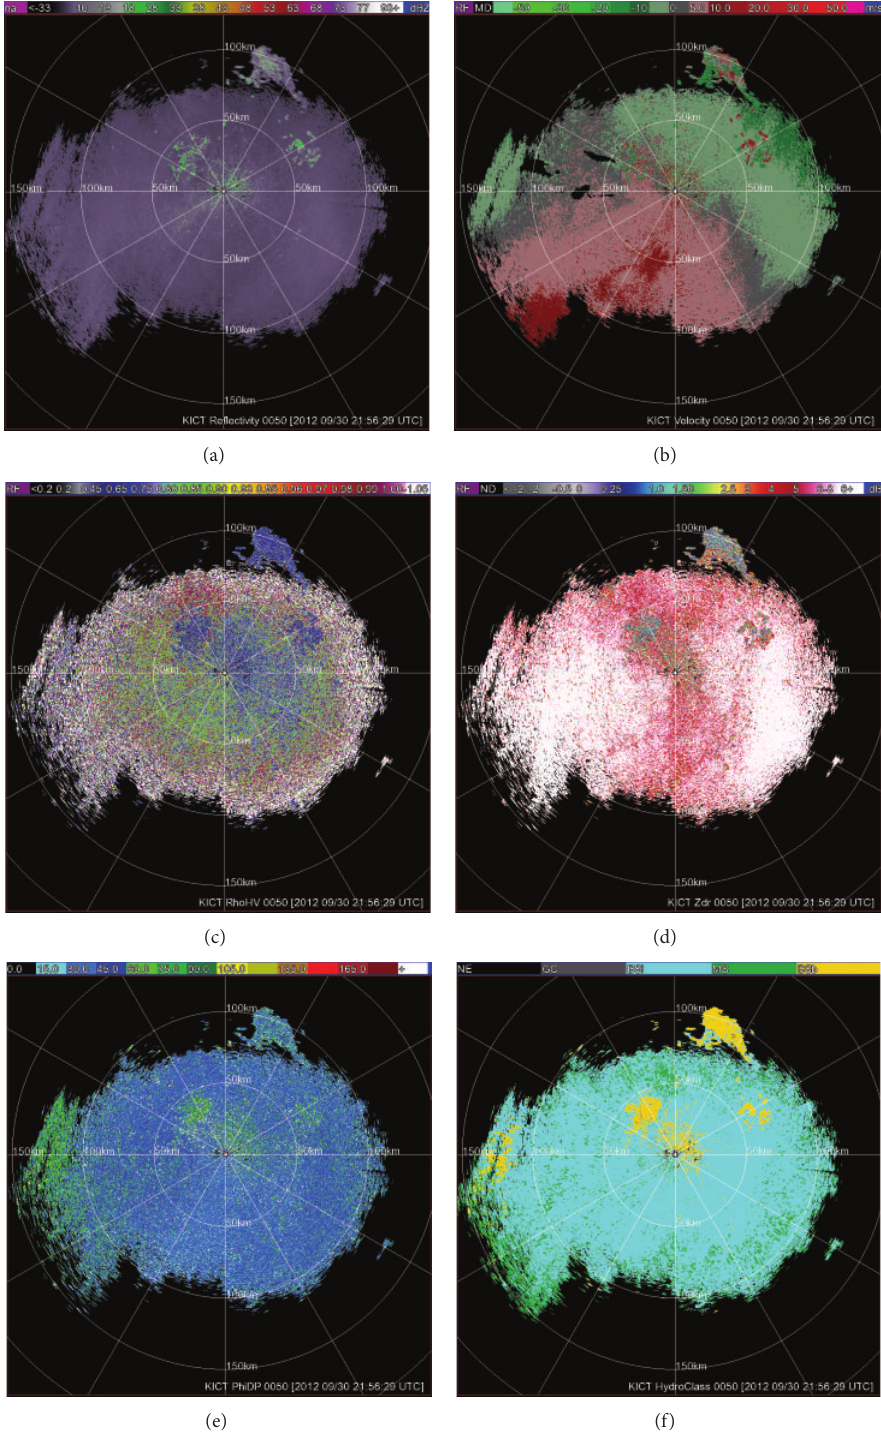
Figure 9: As in Figure 6 but from the KICT 0.5 ∘ scan at 215542 UTC (local time around 4pm) on 30 September 2012.